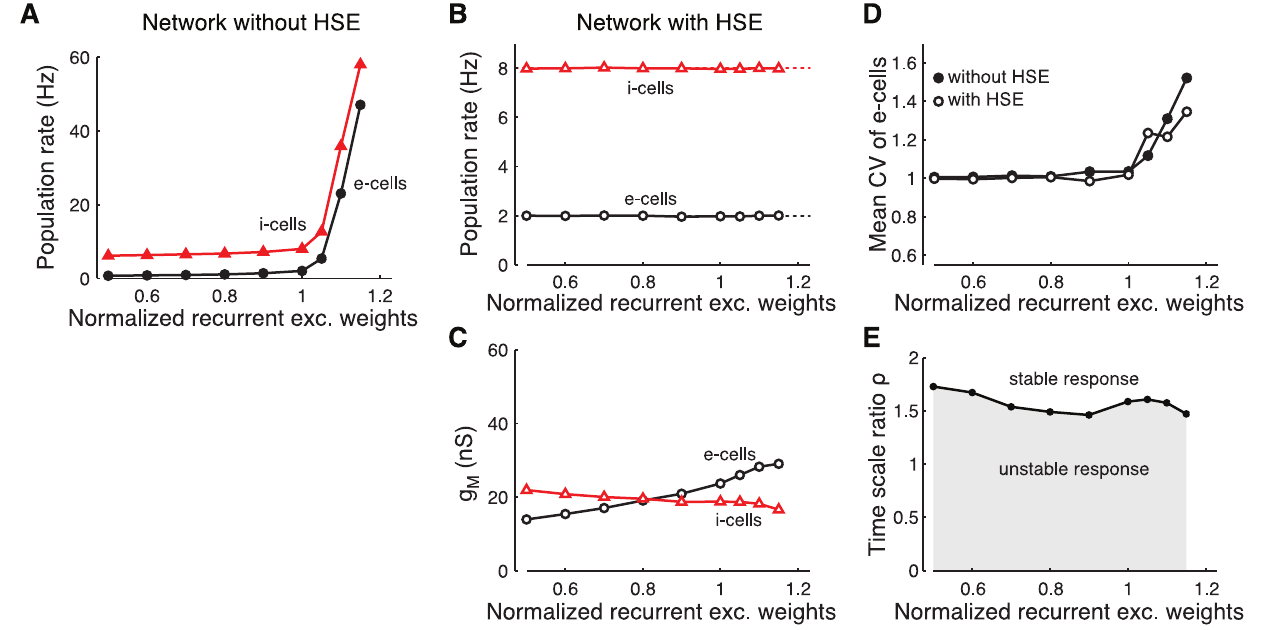
Figure 7. Adapting to plasticity of the recurrent excitatory connection strength. Response of the recurrent network when varying the normalized strength of the recurrent excitatory connections from 0.5 up to 1.15 (see Methods for the standard values). A: Median firing rate of e-cells (circles) and i-cells (triangles) in the network without HSE. B: Median firing rate of e-cells (circles) and i-cells (triangles) in the network with HSE. Dotted lines at 2 and 8 Hz give target rates of both cell types. C: Population mean g M of the e-cells (circles) and i-cells (triangles) in the network with HSE. D: Population mean coefficient of variation of the interspike intervals (CV) of the e-cells in the network without HSE (filled circles) and in the network with HSE (open circles). E: Required ratio of adaptation time scales r for stable adaptation dynamics when the network is perturbed from its adapted state (characterized in panels B and C). The perturbation consists of a 0.3 kHz step increase of the external drive to all cells in the network. The same criterium for stability of the adaptation dynamics is used as in figure 2.